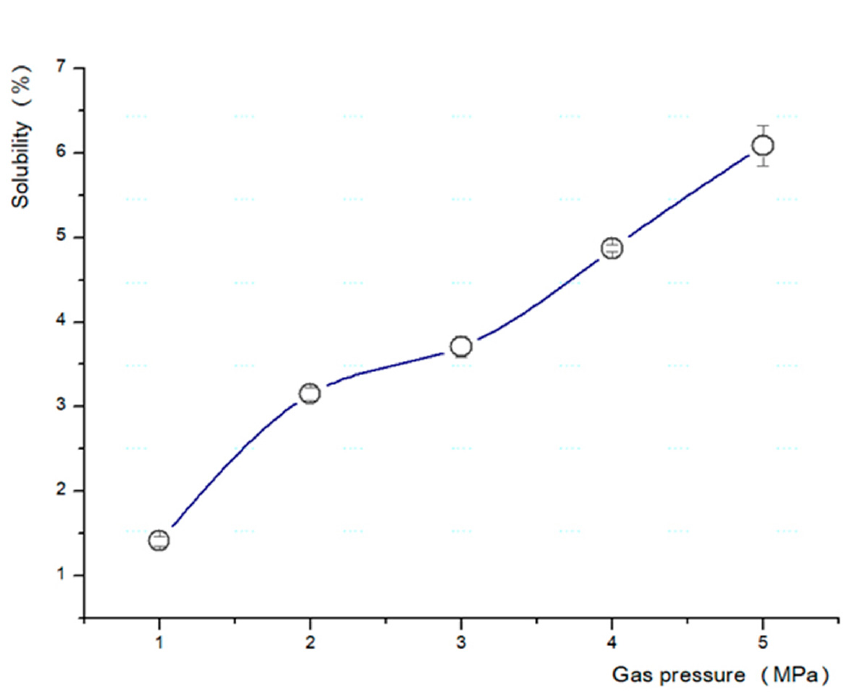
Figure 2. Changes in solubility corresponding to saturation time.